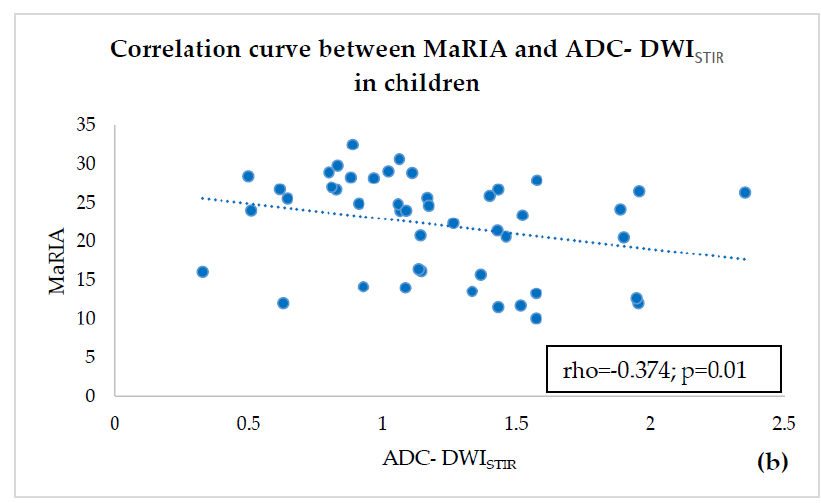
Figure 7. Correlation curve between ADC-DWI STIR and MaRIA in adults ( a ) showing no correlation and in children ( b ) showing low negative correlation.